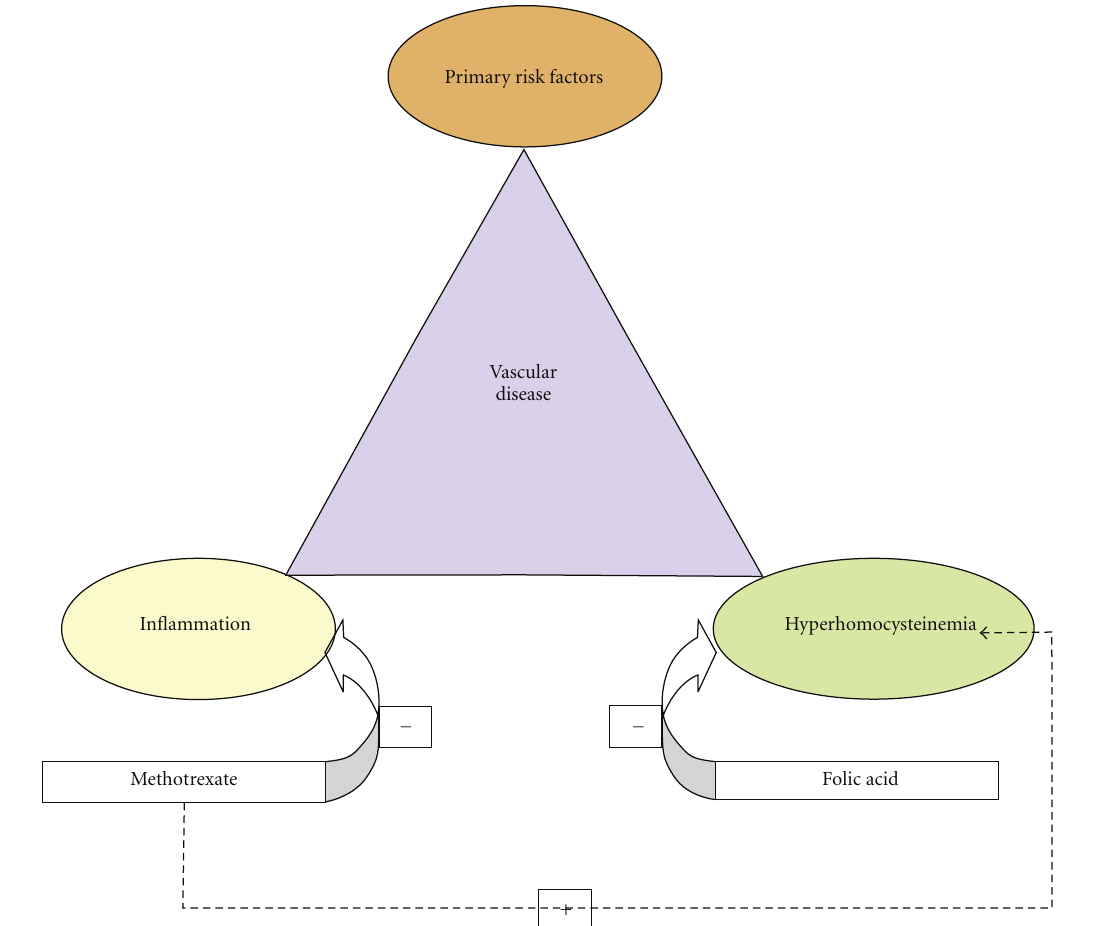
Figure 2: Proposed action of combination therapy, in addition to risk factors such as age, sex, hypertension, and dyslipidemia, homocysteine and inflammation lead to increased incidence of vascular disease. Consequently reducing inflammation with methotrexate and hyperhomocysteinemia by folic acid may lead to a decreased incidence of vascular disease for patients with psoriasis [24]. who have large areas of rapid skin turnover and increased keratinocyte activity, there is excessive consumption of